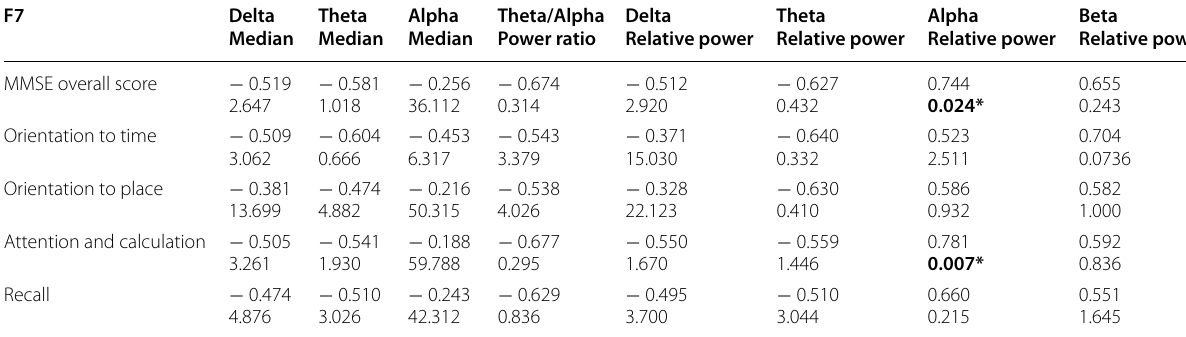
Bold number means positive correlation. First line of each cell represents the Pearson correlation coefficient, and second line represents corrected p -value by multiplying by 280